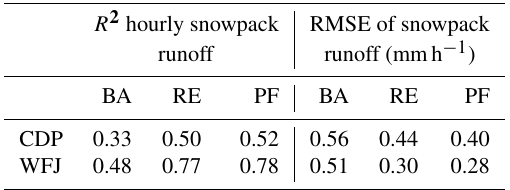
Table 3. R 2 and mean absolute errors for hourly snowpack runoff for 17 and 14 years, for CDP and WFJ,